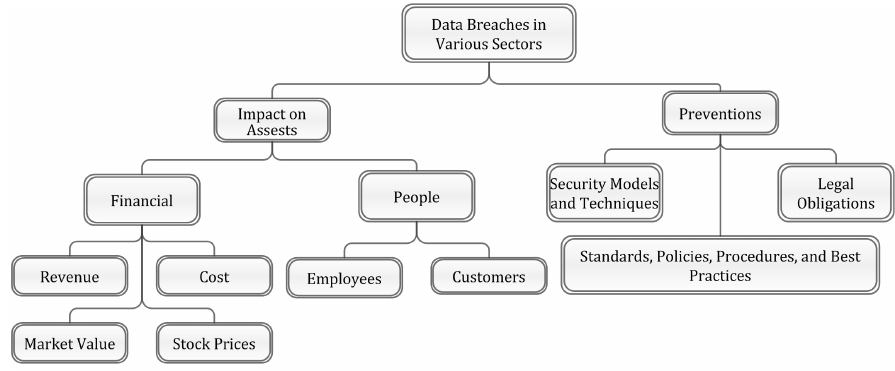
Figure 2. Data Breaches’